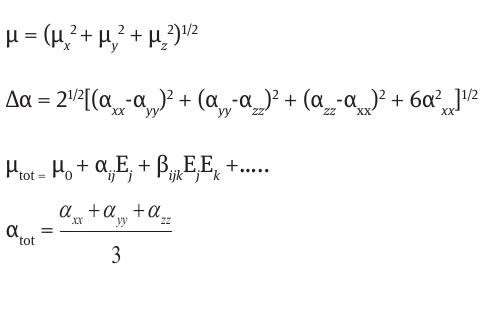
Table 3 : NLO properties of N -acetylisatinthe title compound. 317